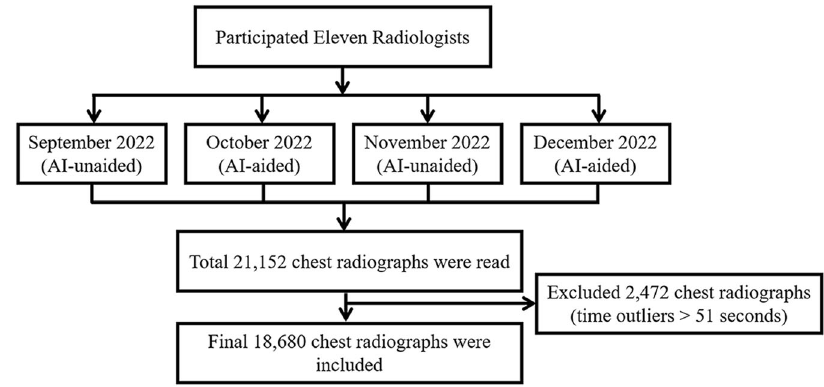
Fig. 1 Flow diagram of the study process. Flow diagram of the study process is